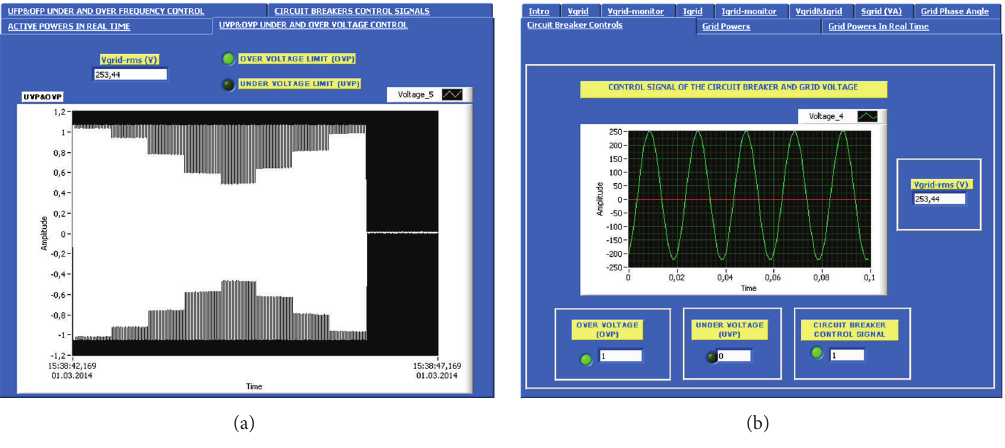
Figure 24: Software interface for over voltage condition.